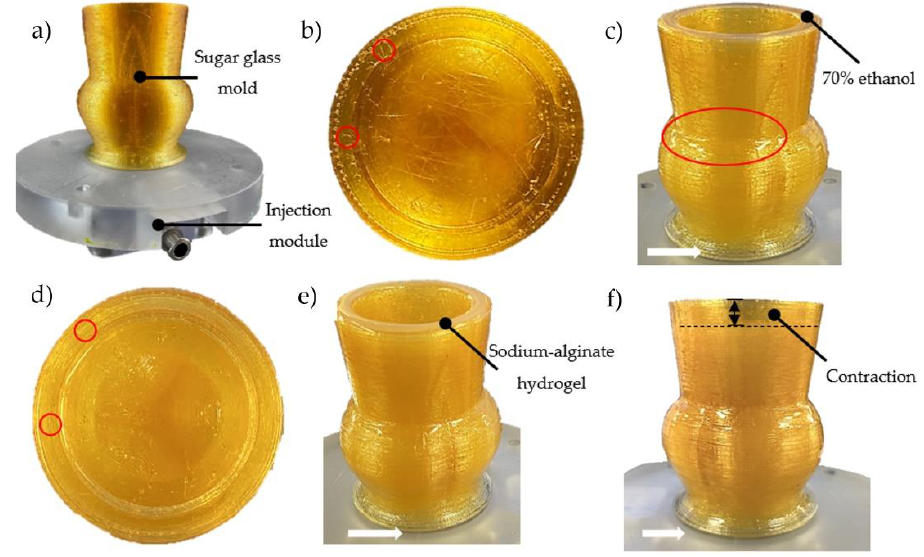
Figure 2. Injection process of the hydrogel scaffold formulation. ( a ) Side view of the mold printed on the injection module. ( b ) Top view of the mold. Small sugar glass filaments were observed after printing (red circles). ( c ) After a short placement in an incubator (37 ° C, 100% relative humidity), the surface of the mold dissolved slightly (glossy finish, outlined in red). The mold was then filled with 70% ethanol. ( d ) Few filaments were left after their dissolution with the ethanol solution (red circles). ( e ) Mold filled with the sodium-alginate hydrogel solution. ( f ) The hydrogel scaffold contracted after gelation compared to ( e ). White arrows: no leakage was observed at the base of the mold at any step.